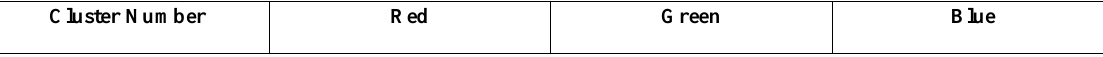
Table 1. Initial centroid for cluster to obtained after series of runs of